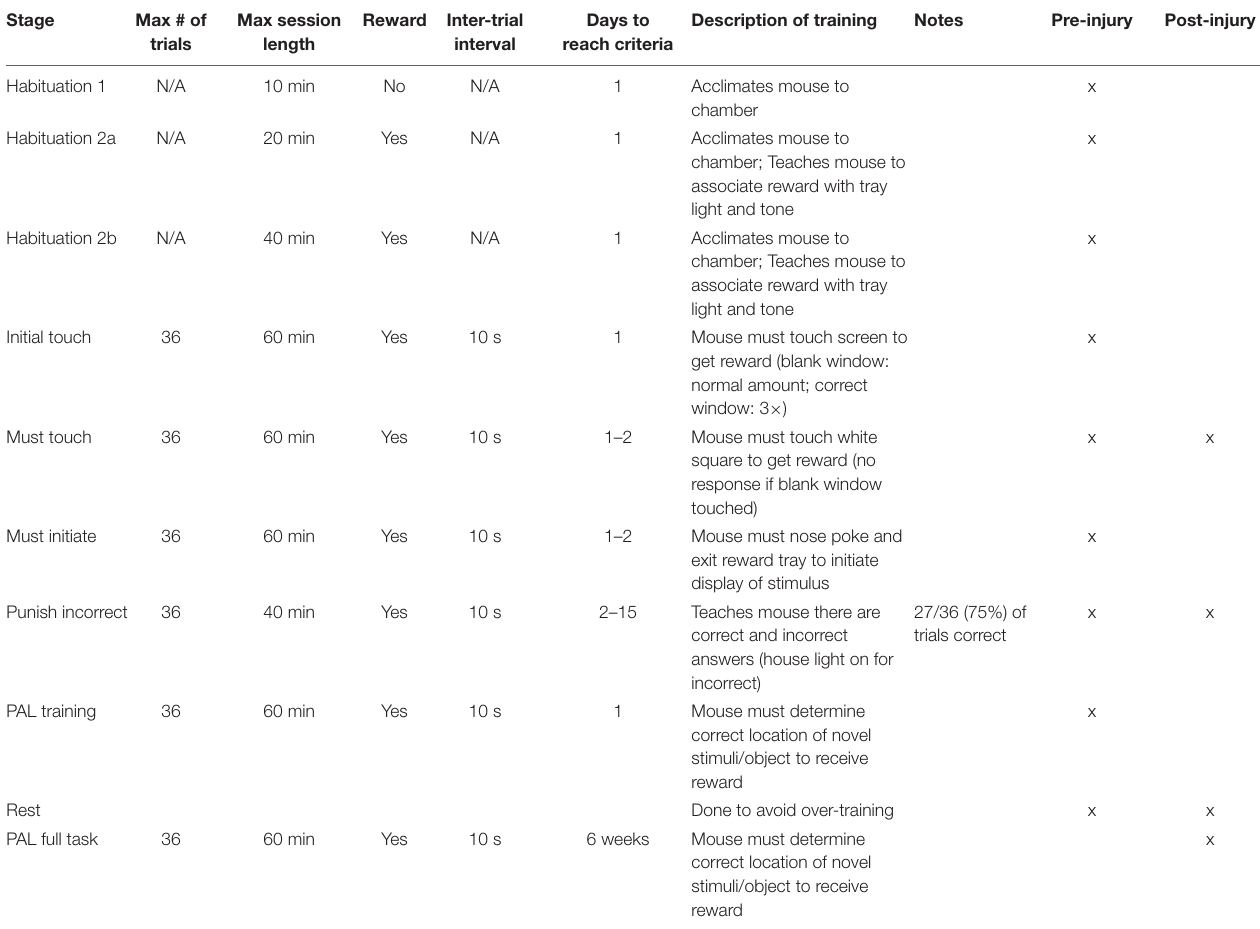
TABLE 1 | Touchscreen operant conditioning training